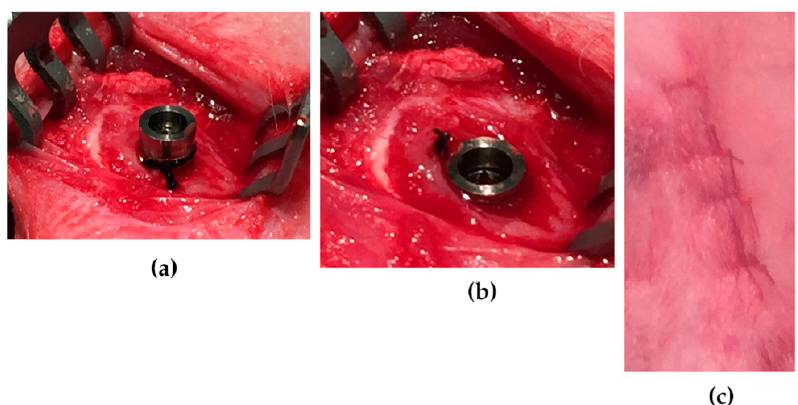
Figure 1. Schematic drawing of implant and ligature placement.